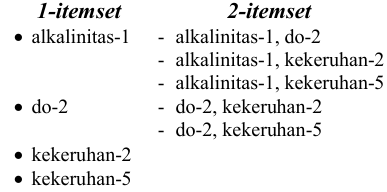
Aturan Asosiasi dengan Standar STORET pada Model Prediksi Parameter Pendukung Uji Kualitas